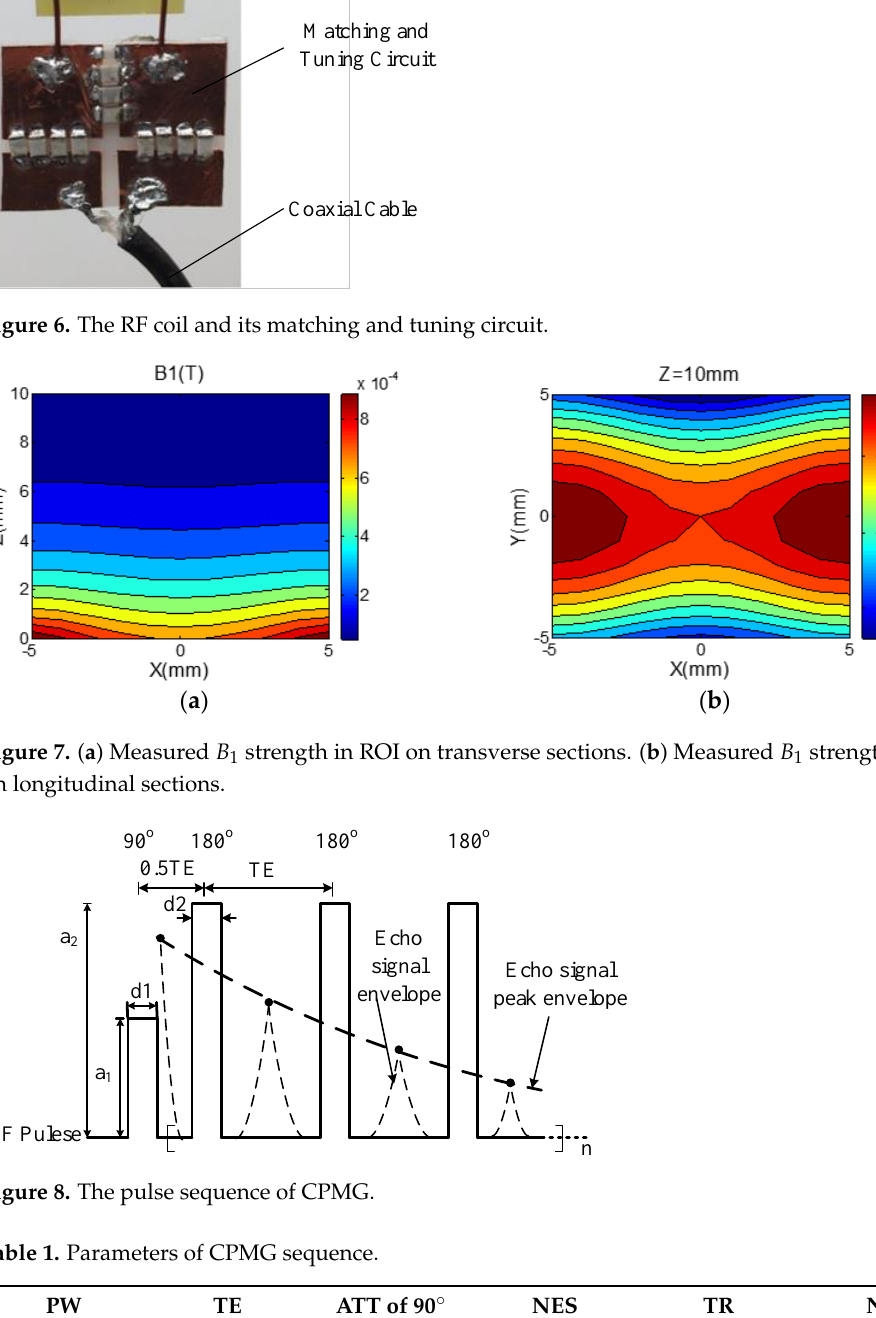
Figure 6. The RF coil and its matching and tuning circuit.